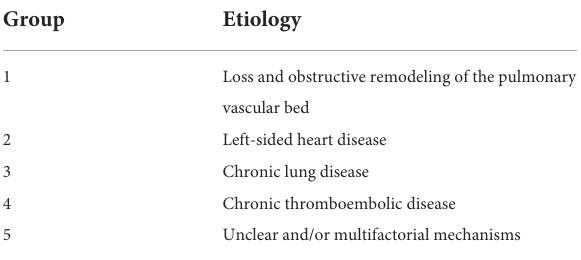
TABLE 1 Pulmonary hypertension